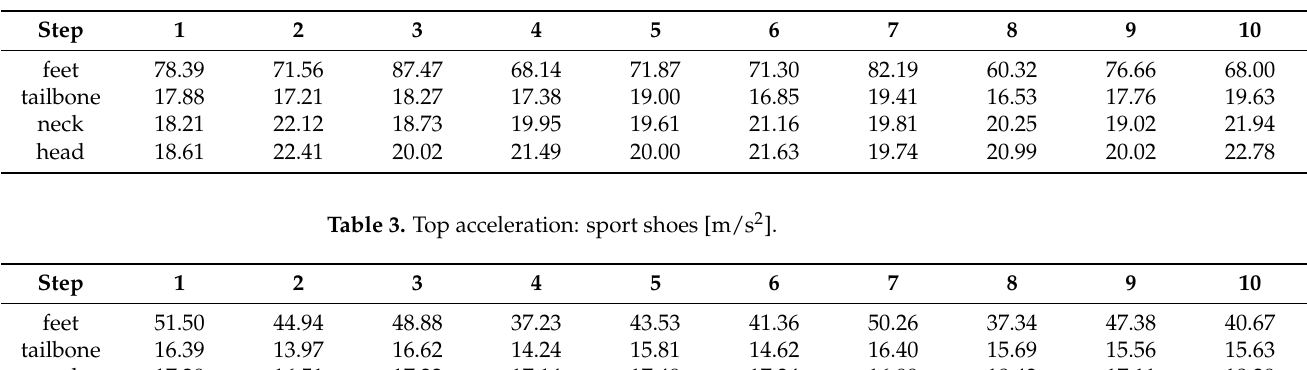
Table 2. Top acceleration: bare feet [m/s 2 ].